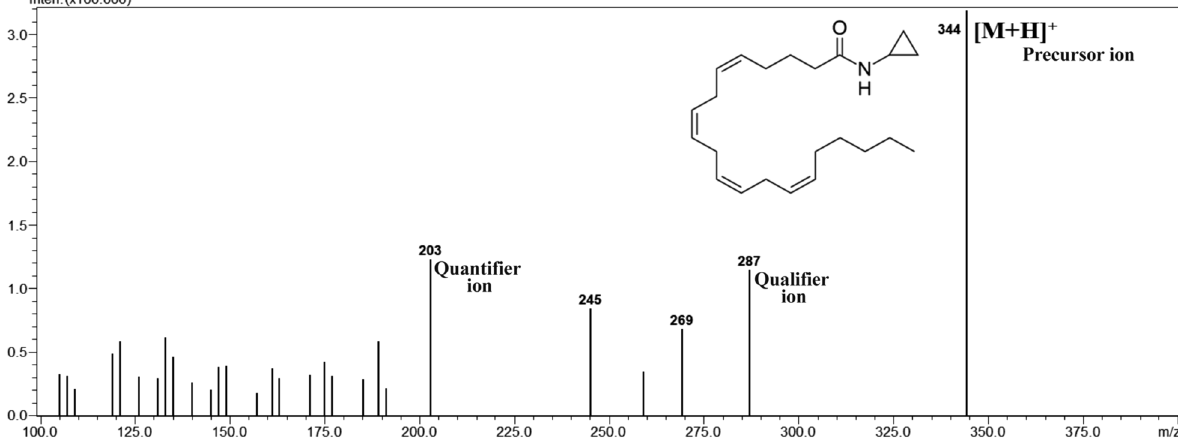
Fig. 1 MS/MS fragmentation pattern of ACPA (Quantifier ion: 203 m/z, qualifier ion: 287 m/z, CE: